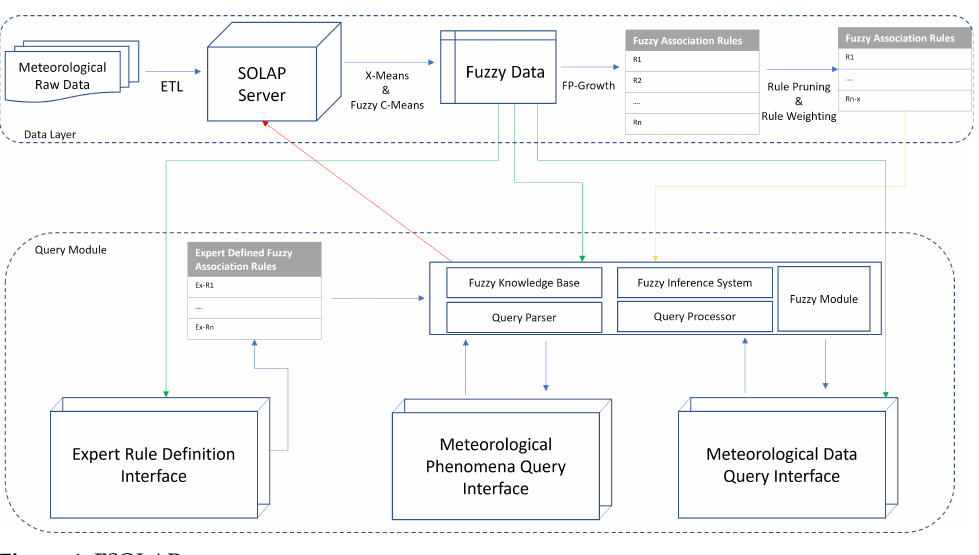
Figure 4. FSOLAP query